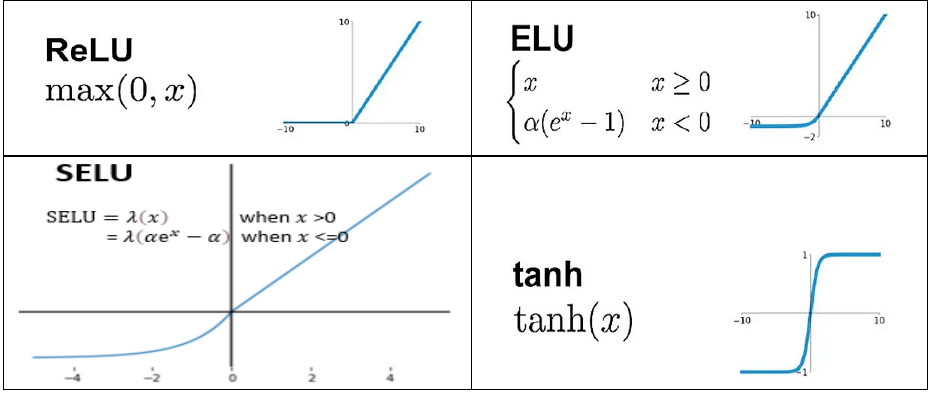
Figure 5. Mathematical Expressions of ReLU, ELU, SELU, and Tanh activation functions.